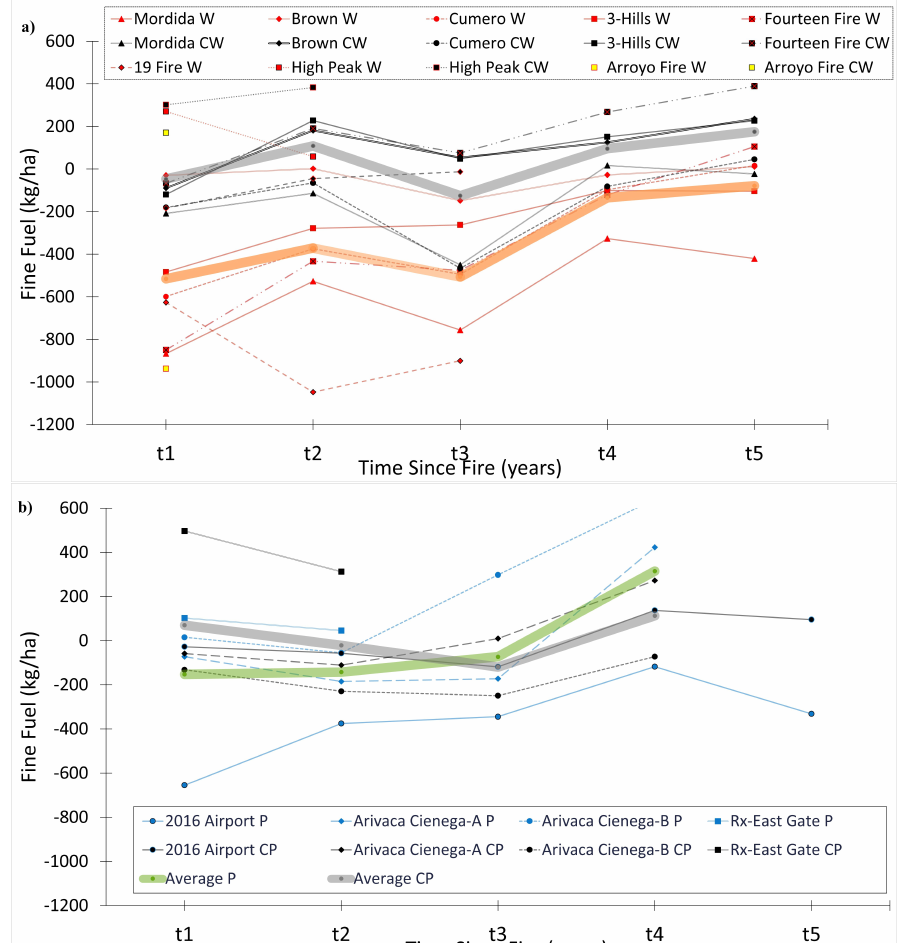
Figure 6. Changes in post-fire fine-fuel (kg/ha) for ( a ) naturally occurring wildfires (W; red) and ( b ) prescribed (P) fires (blue), with comparable unburned control areas (C; black), surrounding burn perimeters, in relation to time since fire (t1 = 1 year post fire) at BANWR. Average post-wildfire (orange), average post-prescribed fire (green), average control of wildfire (CW; gray), and average control of prescribed fire (CP; gray) fine-fuel. Note : t0 (not shown) = year of